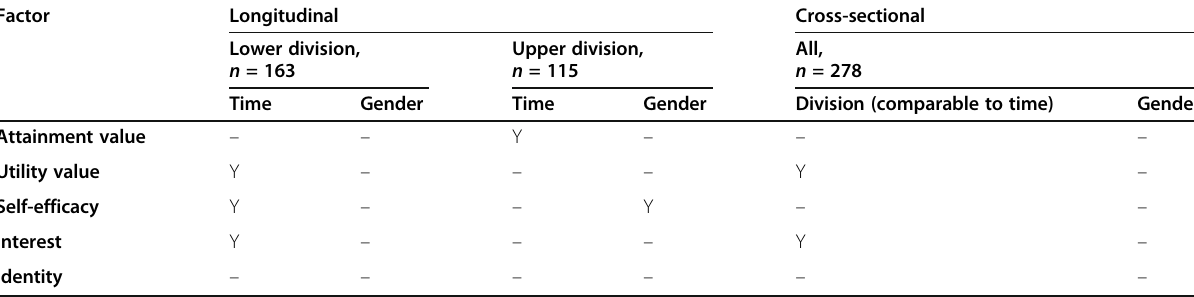
Table 3 Summary of significant results from RMANOVA and ANOVAs Factor Longitudinal Cross-sectional Lower division, n = 163 Attainment value Self-efficacy Y